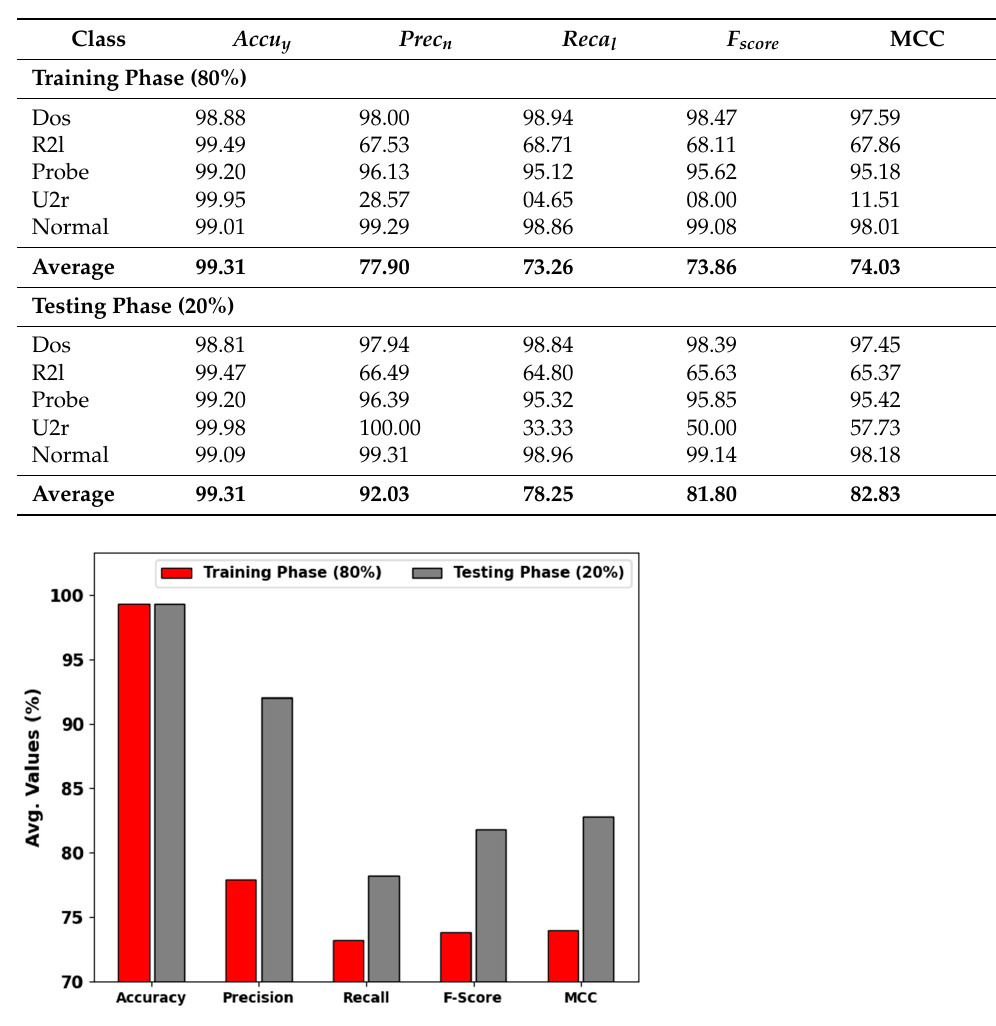
Figure 4. Average outcome of IMFL-IDSCS system under 80:20 of TR/TS databases. Table 3. Result analysis of IMFL-IDSCS system under 70:30 of TR/TS Table 3 and Figure 5 provide the overall intrusion recognition outcomes of the IMFL- IDSCS model on 70% of TR and 30% of TS databases. The outcomes exhibit that the IMFL- IDSCS method showed maximum outcome under all classes. For the sample, on 70% of the TR database, the IMFL-IDSCS approach presented an average 𝑎𝑐𝑐𝑢 (cid:3052) of 99.37%,